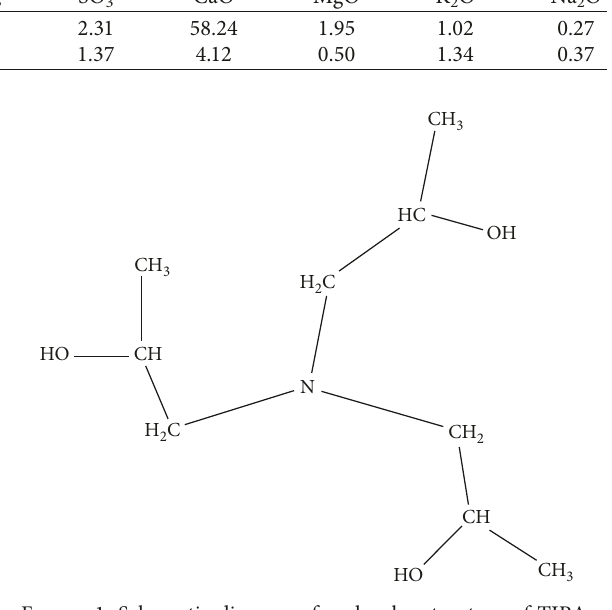
Figure 1: Schematic diagram of molecular structure of